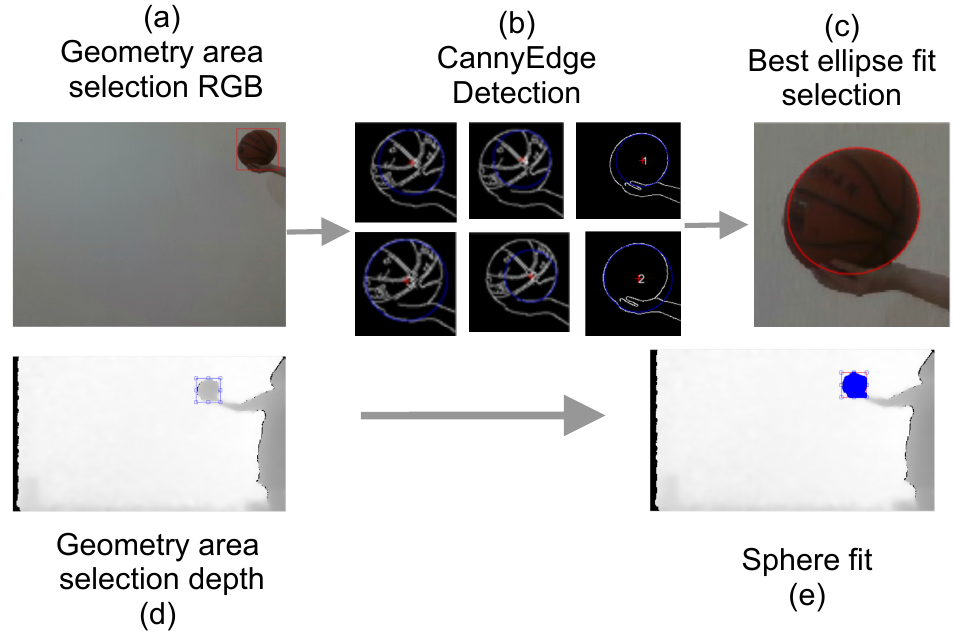
Figure 5. Staranowicz’s method detects a basketball as a geometry object in both layers, color, and depth, but it requires one hundred and thirty image pairs during the calibration protocol. This requirement increases the calibration protocol complexity